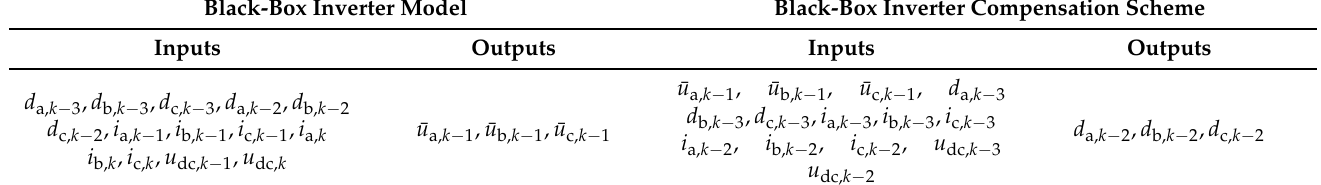
Table 1. Input and output parameters for both research models ( d a : duty cycle phase A; d b :